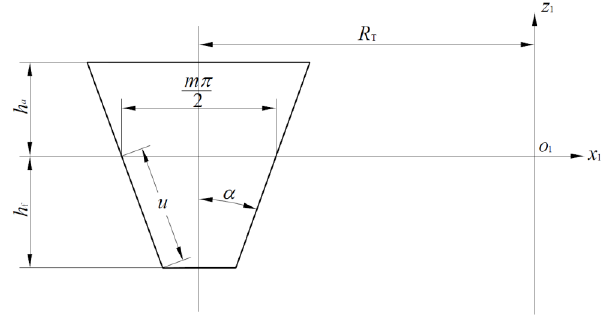
Figure 2. The geometric shape and parameters of the cutting